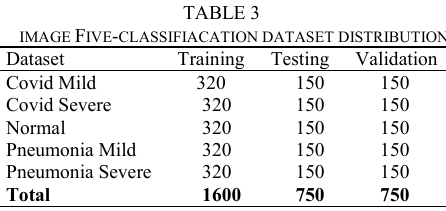
TABLE 3 IMAGE F IVE - CLASSIFIACATION DATASET